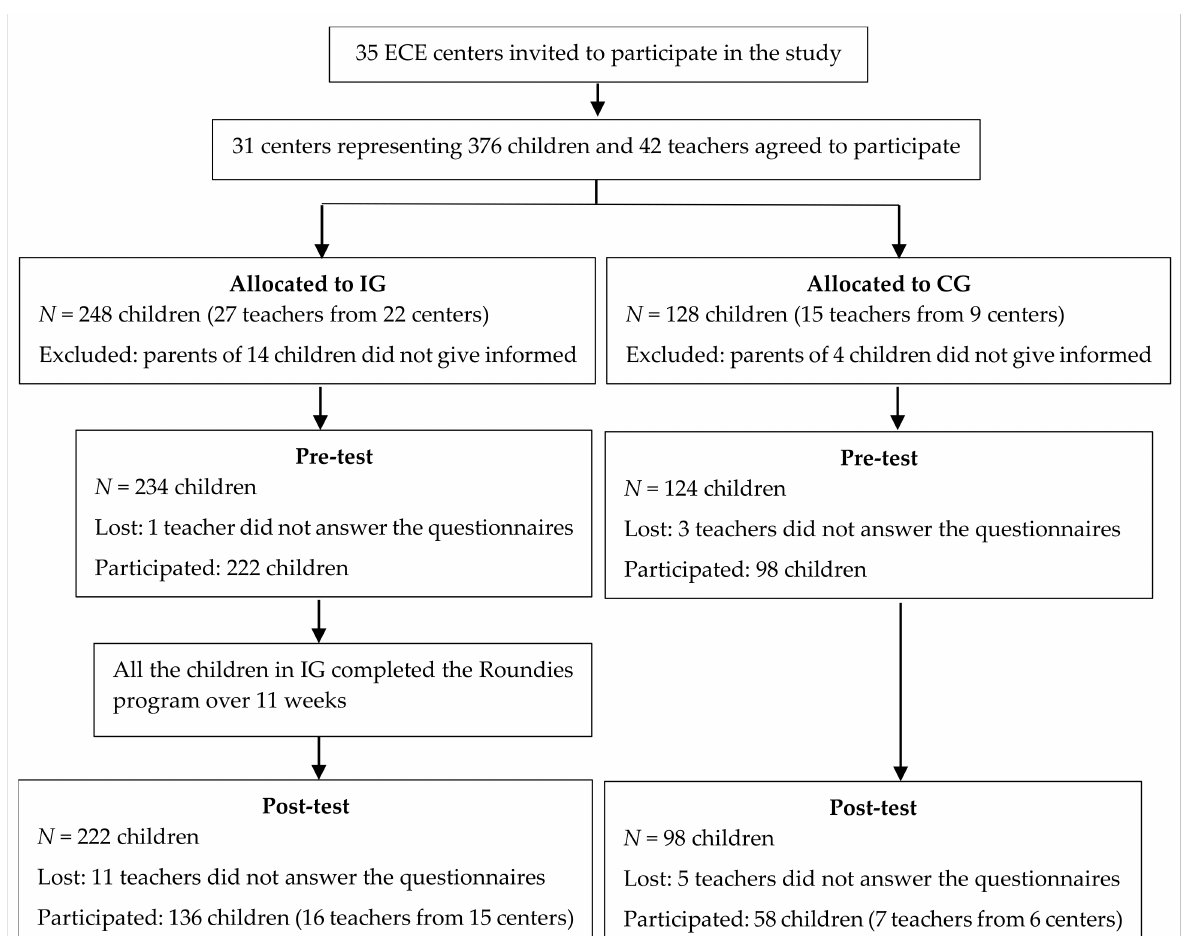
Figure 1. Flowchart of the study design and the number of corresponding